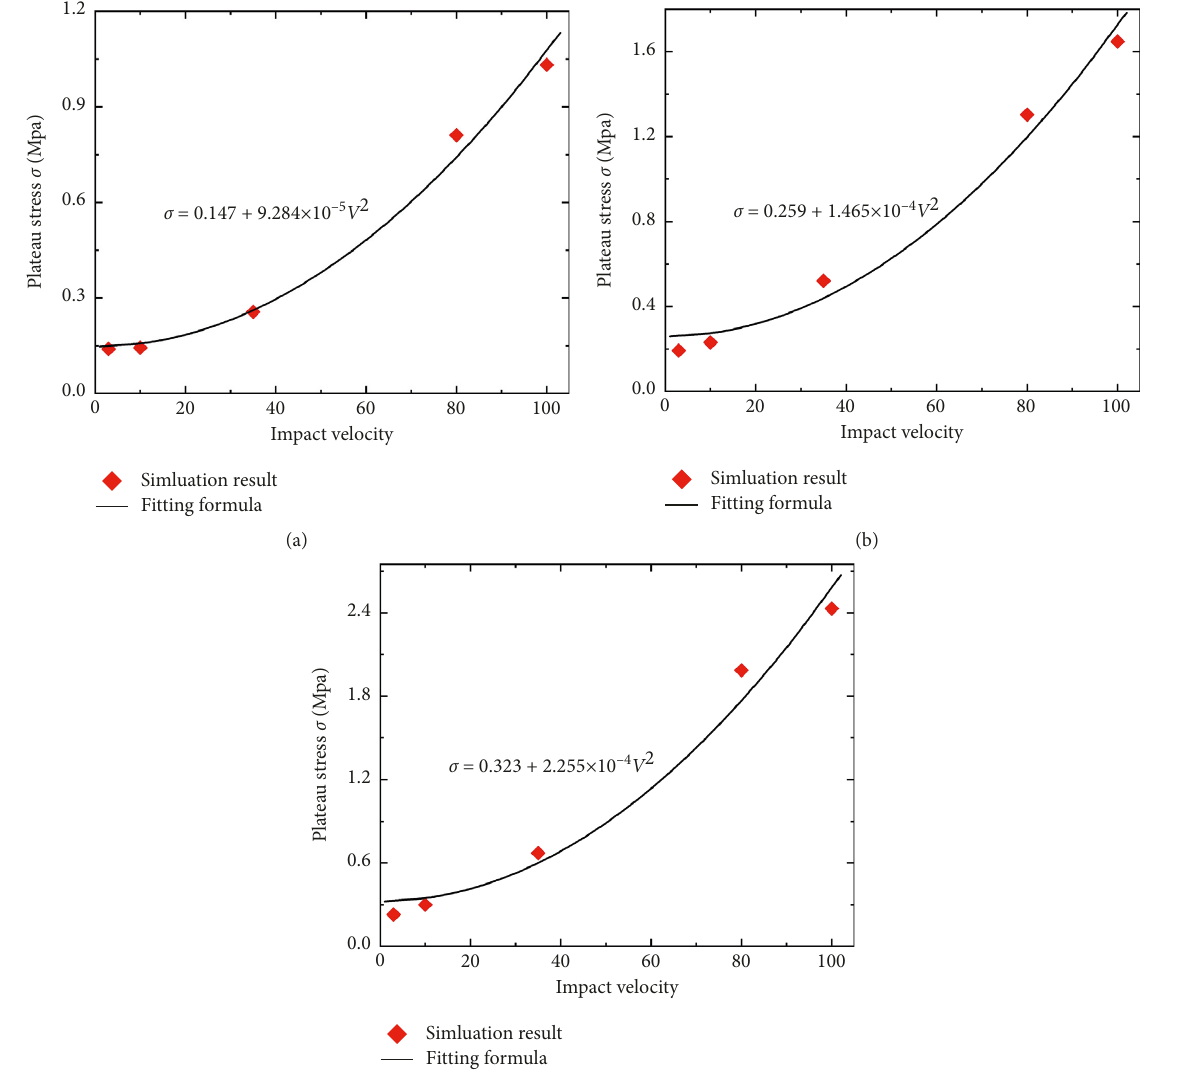
Figure 9: Plateau stresses of three honeycombs: (a) regular hexagonal honeycomb (RHH), (b) HKH, and (c) Kagome honeycomb